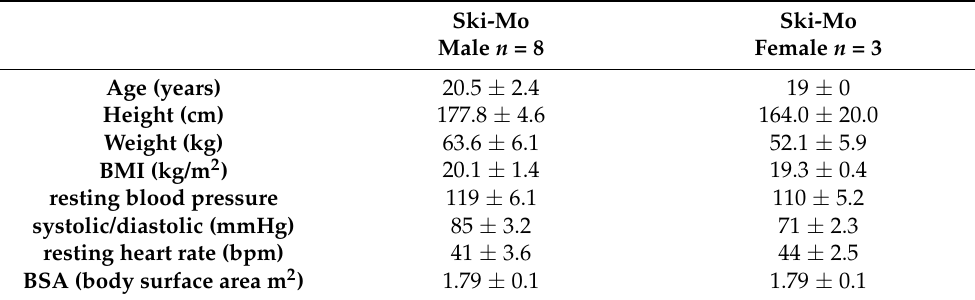
Table 1. Baseline anthropometric Ski-Mo characteristics.